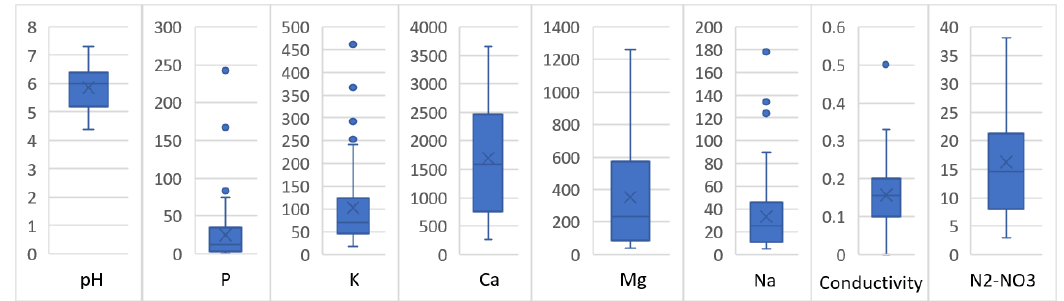
Figure 8. Variables statistics of the 100 soil samples (pH, P, K, Ca, Mg, Na, conductivity, and N 2 -NO 3 ).